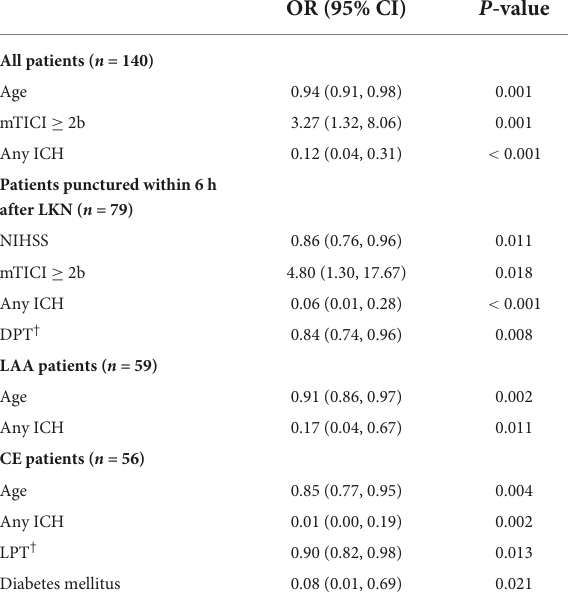
TABLE 2 Predictors of functional independence (mRS, 0–2) at 90